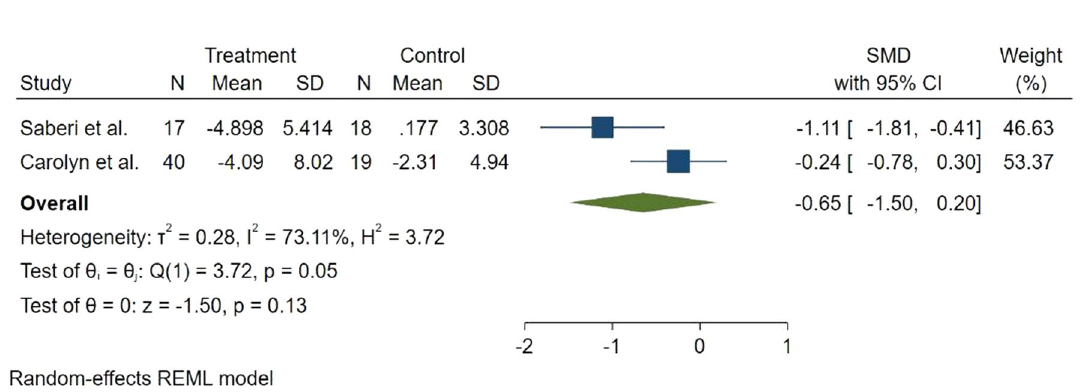
Fig. 7 Forest plot for ejection fraction